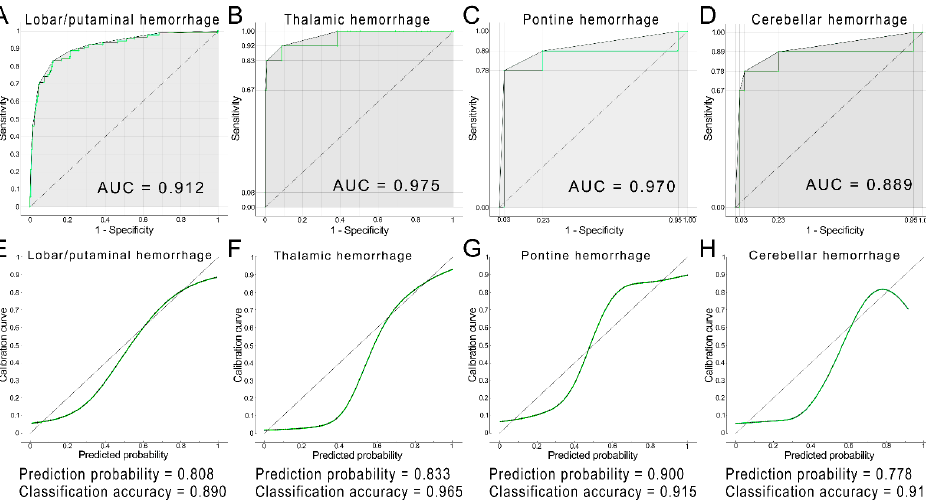
Figure 2. Area under the receiver operating characteristic curve of the nomogram for internal 5-fold cross-validation of death due to lobar/putaminal hemorrhage ( A ), thalamic hemorrhage ( B ), pontine hemorrhage ( C ), and cerebellar hemorrhage ( D ). Calibration curve of nomograms for the predicted probability of death due to lobar/putaminal hemorrhage ( E ), thalamic hemorrhage ( F ), pontine hemorrhage ( G ), and cerebellar hemorrhage ( H ). AUC, area under the curve.